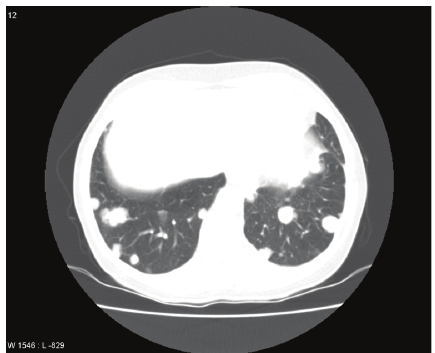
Figure 1: Sagittal computed tomography scan of the chest showing local relapse in the lower inner quadrant of the breast after breast conserving surgery and adjuvant treatment.